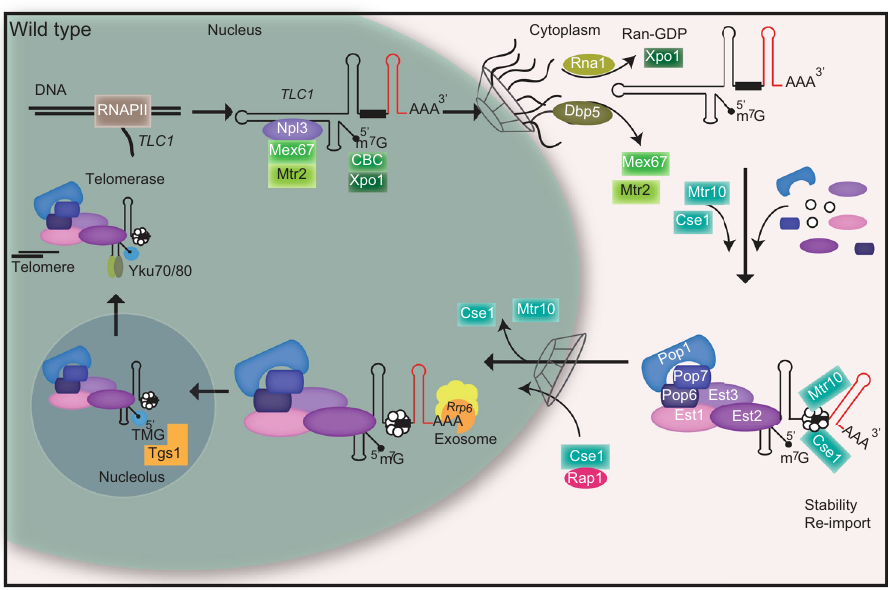
Figure 7. Model for the compartmental stepwise maturation of TLC1 . The longer precursor of TLC1 is transcribed in the nucleus and immediately exported into the cytoplasm upon binding of the export receptor Mex67-Mtr2 and the karyopherin Xpo1/Crm1, the latter of which interacts with CBC bound m 7 G-caps. Upon export, Mex67 and Xpo1/Crm1 are displaced and the Sm-ring, the Est and the Pop proteins assemble on the immature TLC1 in the cytoplasm. Subsequently, this RNP is re-imported back into the nucleus via Mtr10 and Cse1, both of which contact TLC1 via its Sm-ring. Thus, nuclear re-import can only occur after RNP formation including the Sm-ring and therefore resembles an important quality control checkpoint. In the nucleus,